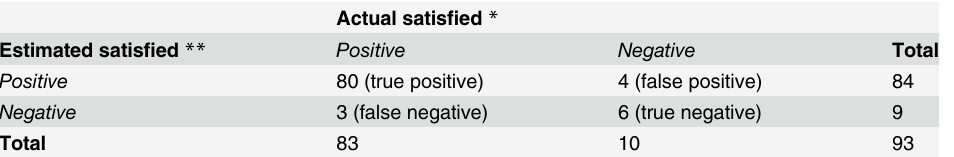
Table 2. Two-by-two matrices of the relationship between the estimated satisfied and the actual satis- fied (sensitivity analysis). Actual satis fi ed * Estimated satis fi ed **